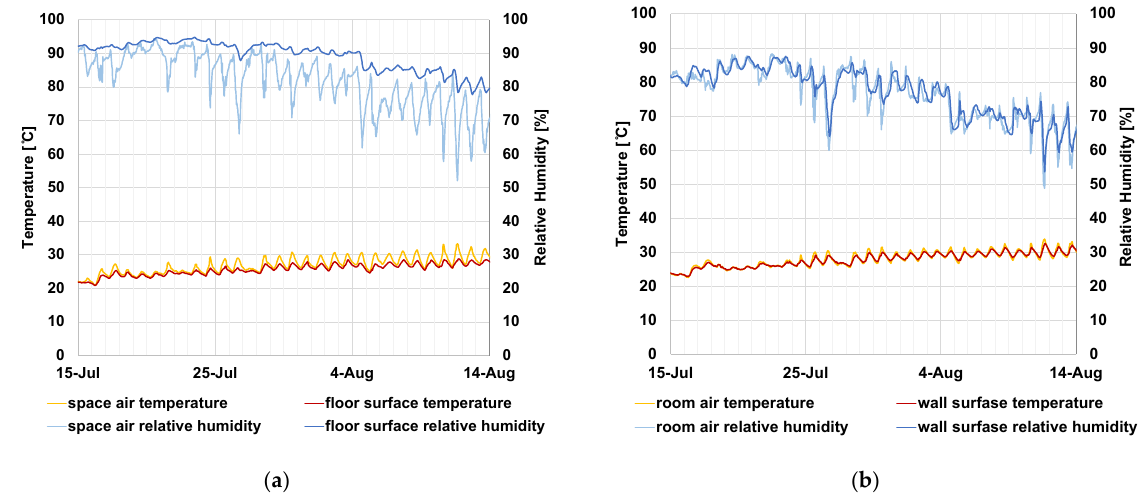
Figure 5. The calculation results of surface temperature (°C ) /relative humidity (%) and the measured values of air temperature/humidity of the ( a ) earth floor and ( b ) Japanese-style room wall.